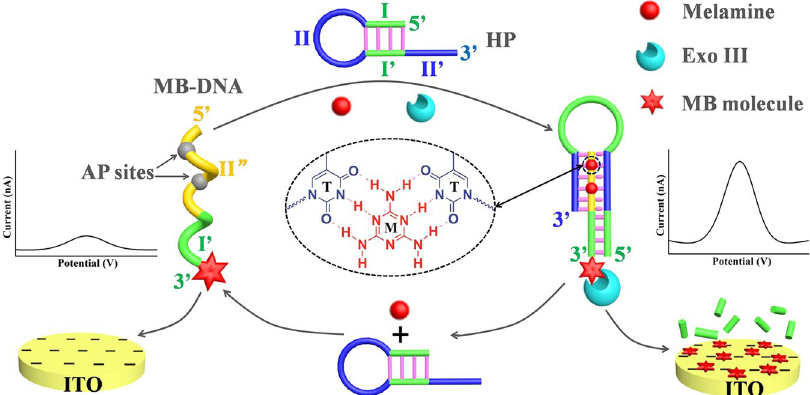
Figure 1. Principle of the homogeneous electroanalytical strategy for melamine